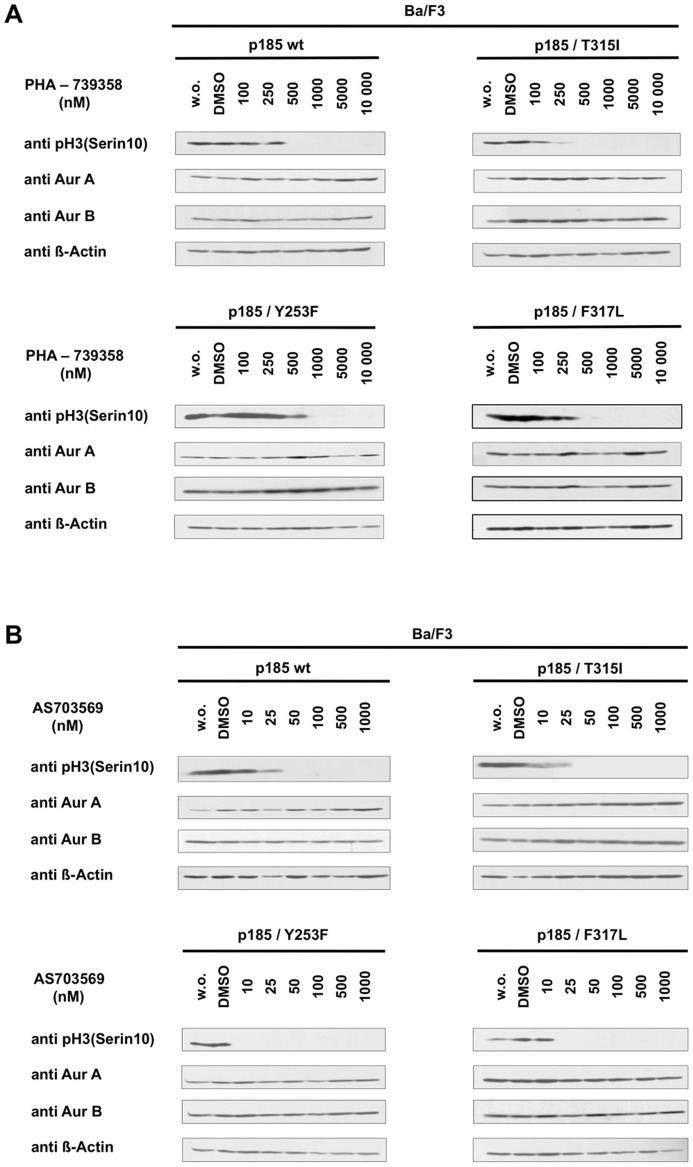
Inhibition of Aurora kinase activity occurs at different concentrations of PHA-739358 and R763/AS703569.Ba/F3 p185 wt, p185/T315I, p185/Y253F and p185/F317L cells were treated with indicated concentrations of PHA-739358 (A) or R763/AS703569 (B) for 2.5 h. Aurora Kinase activity assessed by phosphorylation status of Histone-H3 at Serine-10 was analyzed using immunoblotting. Control cells were left untreated or exposed to DMSO.